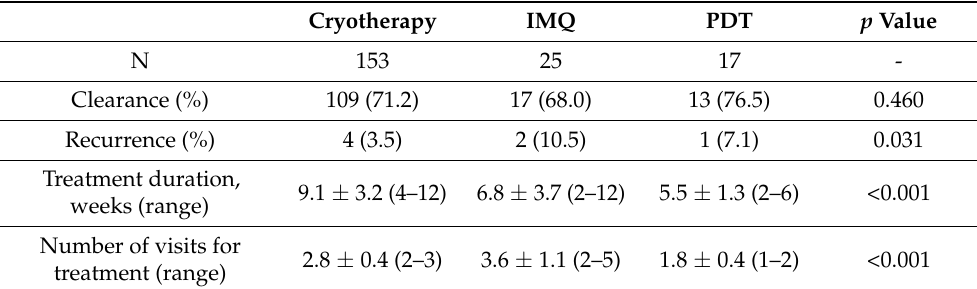
Table 2. Clearance rates, recurrence rates, average treatment duration, and number of visits by treatment